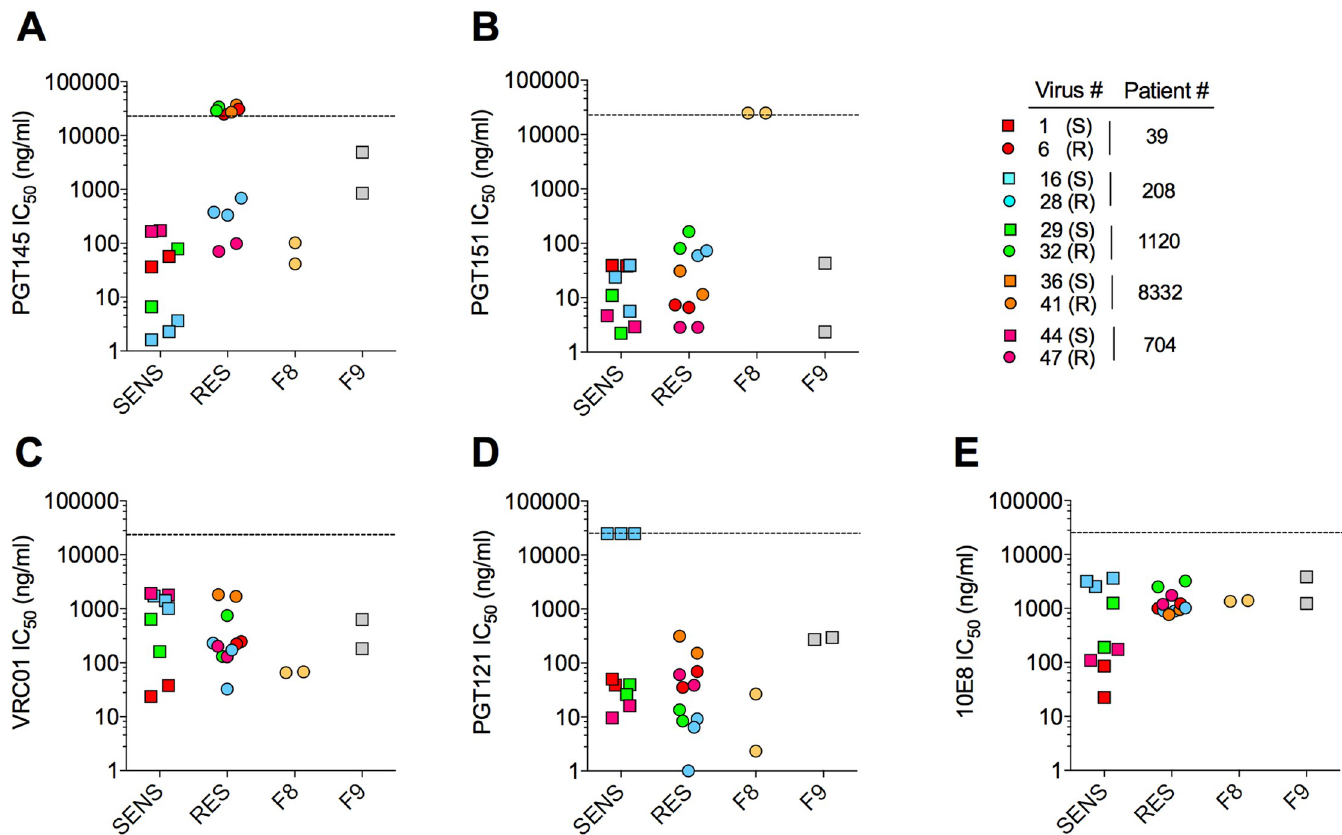
Fig 3. Sensitivity of CXCL12-SENS and CXCL12-RES viruses to broadly neutralizing antibodies. Viruses pseudotyped with SENS, RES, F8 or F9 Envs were exposed to bNAbs and then incubated with TZM-bl cells. For each Env/bNAb pair, the IC 50 s from two or three independent experiments are shown. The dashed line indicates the highest antibody concentration used (25,000 ng/ml). A data point on the dashed line indicates that IC 50 > 25,000 ng/ml.